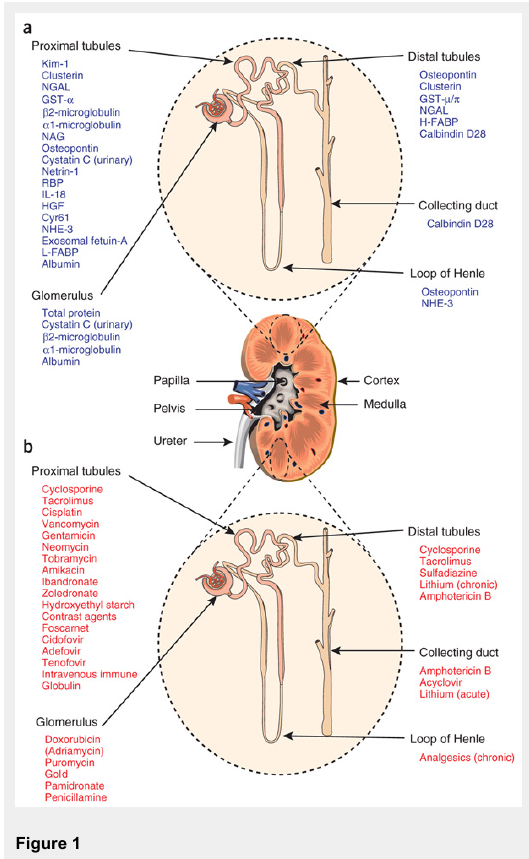
The utility of biomarkers to detect injury to specific nephron segments affected by various nephrotoxins. a Nephron segment-specific biomarkers of kidney injury. b Drugs that elicit site-specific toxicity in the kidney. (Source: Bonventre JV, Vaidya VS, Schmouder R, Feig P, Dieterle F. Next-generation biomarkers for detecting kidney toxicity. Nat Biotechnol. 2010;28:436–40. © Macmillan publishers Ltd, 2012. Reprinted with